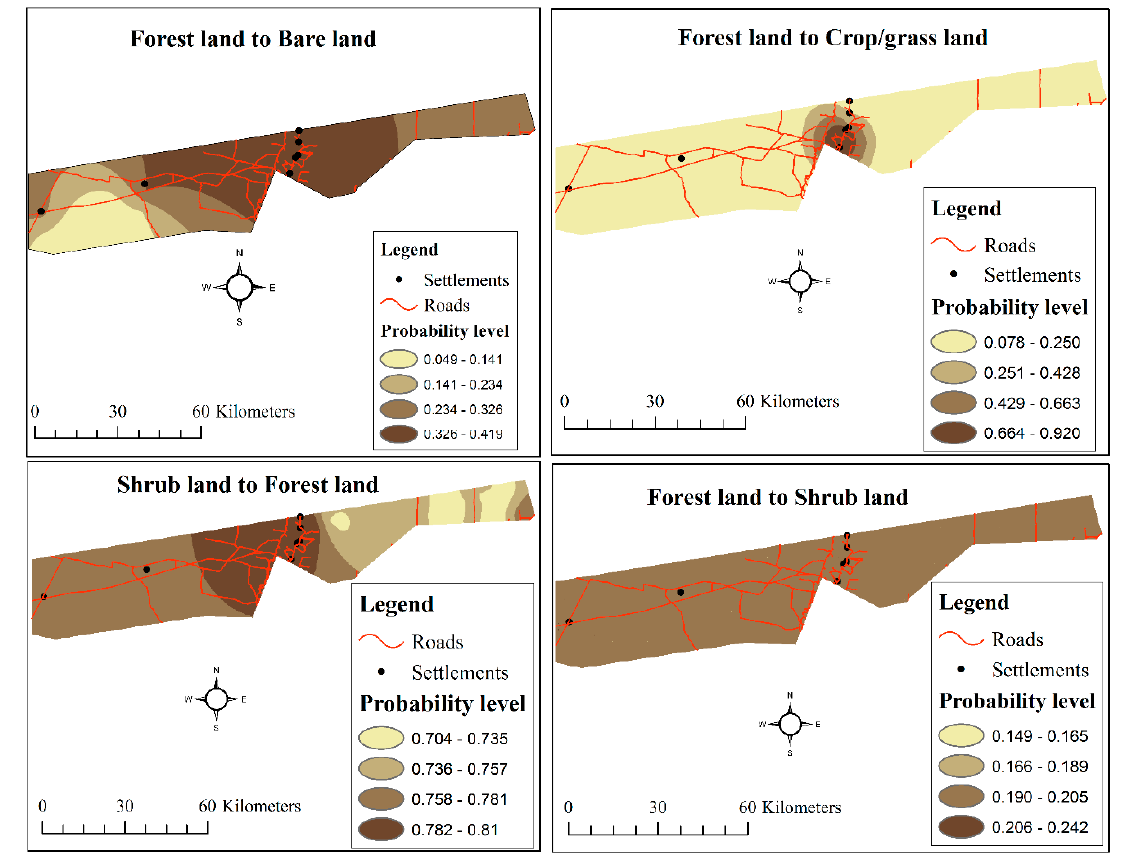
Figure 4. Probability of occurrence for the selected LULC conversions in the protected area. Table 7. Factors affecting the LULC class/conversion in the communal